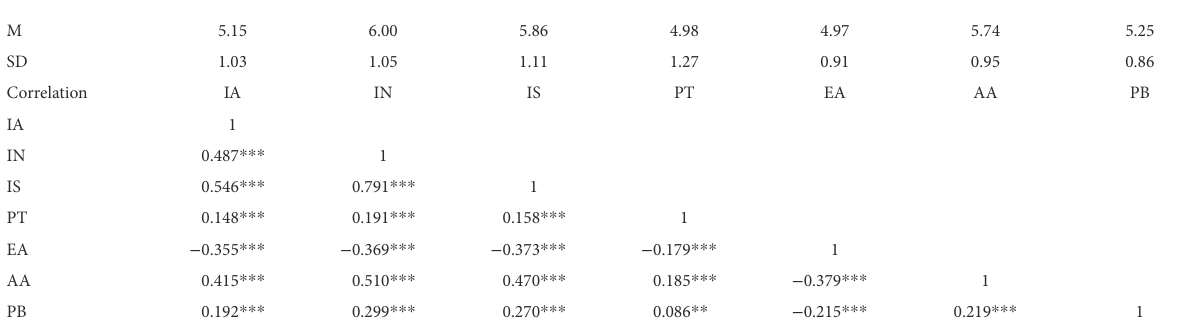
TABLE 3 Means, standard deviation, and correlation.